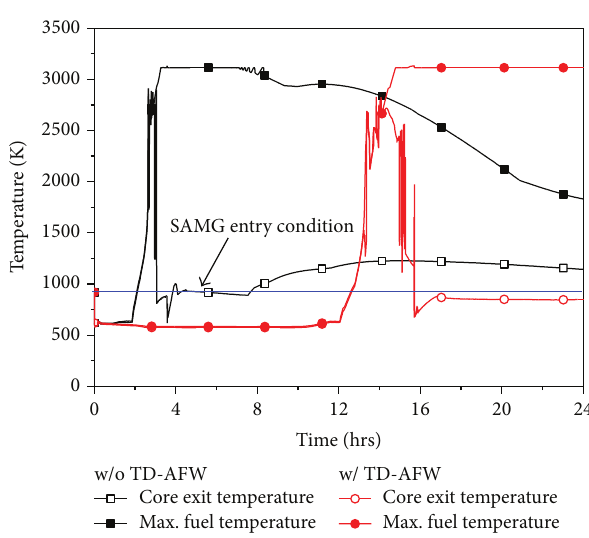
Figure 5: SG water level.